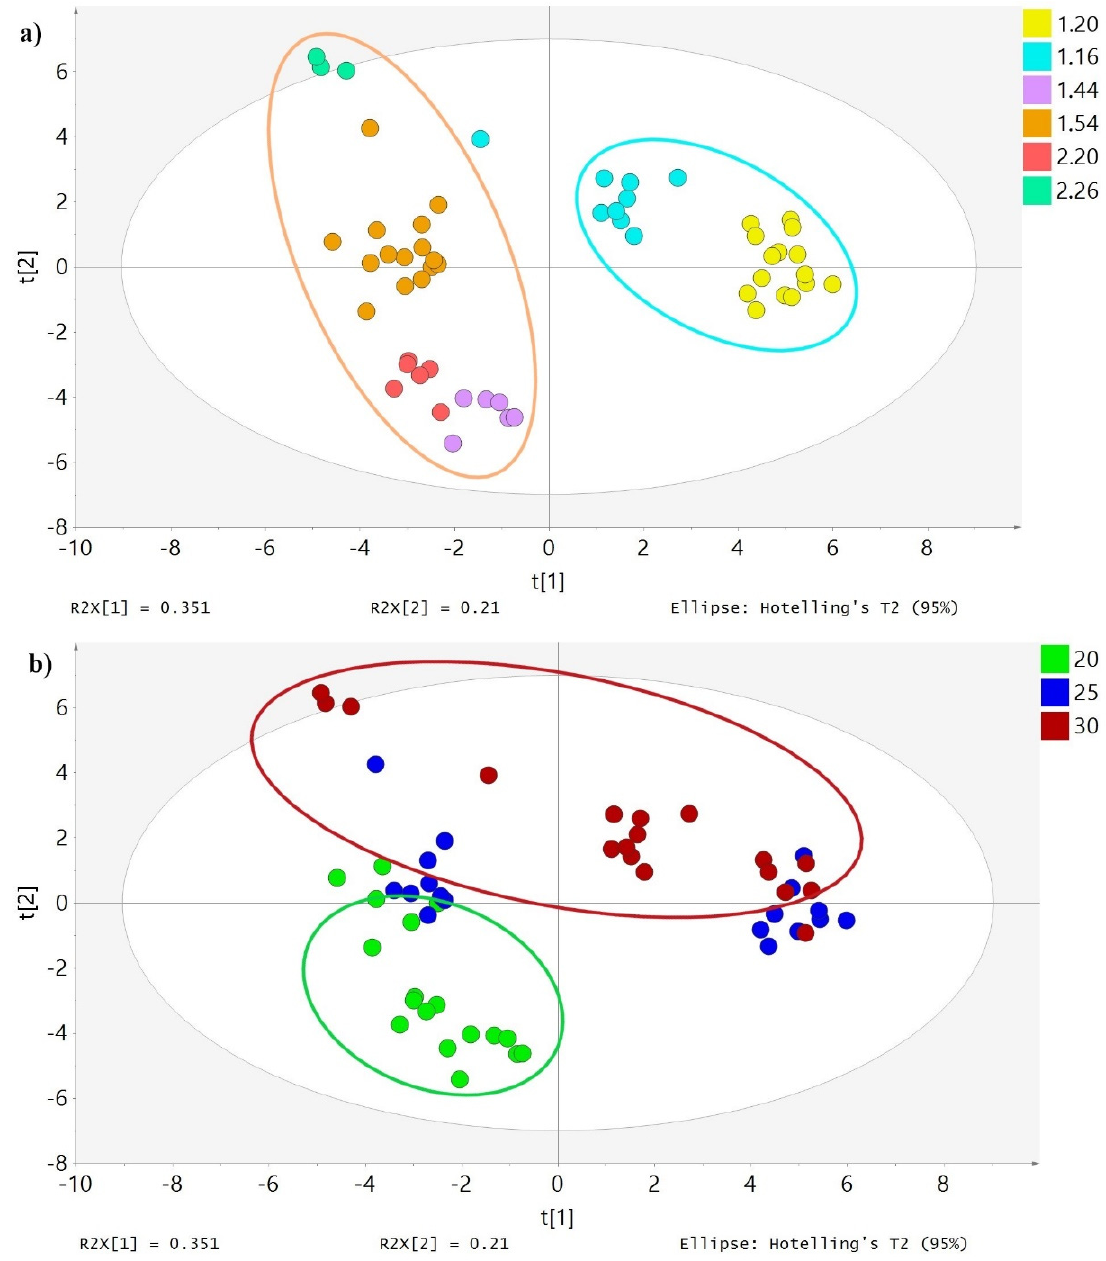
Figure 1. Score scatter plot of the EVOO samples. Figure ( a ) shows the EVOO samples colored according to their RI (1.20, 1.16, 1.44, 1.54, 2.20, and 2.26). Figure ( b ) shows the EVOO samples colored according to the malaxation temperature (20, 25, and 30 °C).